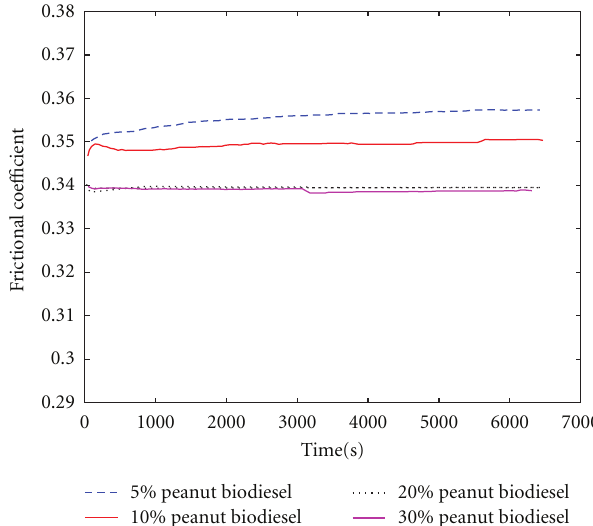
Figure 5: Friction force versus time for peanut oil biodiesel diluted engine oil